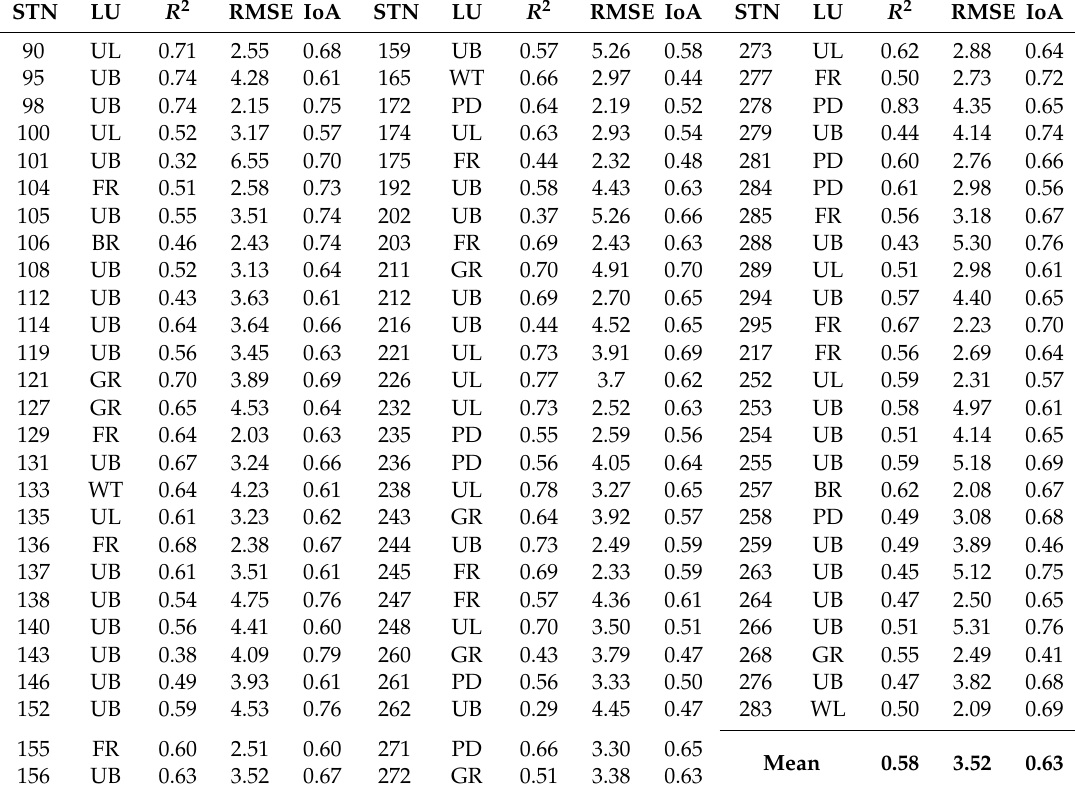
Table A1. The T MN prediction model results from 79 meteorological stations during the cold wave